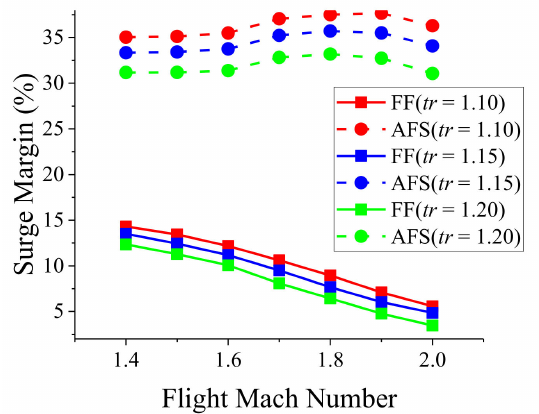
Figure 21. The Variations of Surge Margins of Front Fan and AFS at the conditions of Different Throttle Ratio ( tr